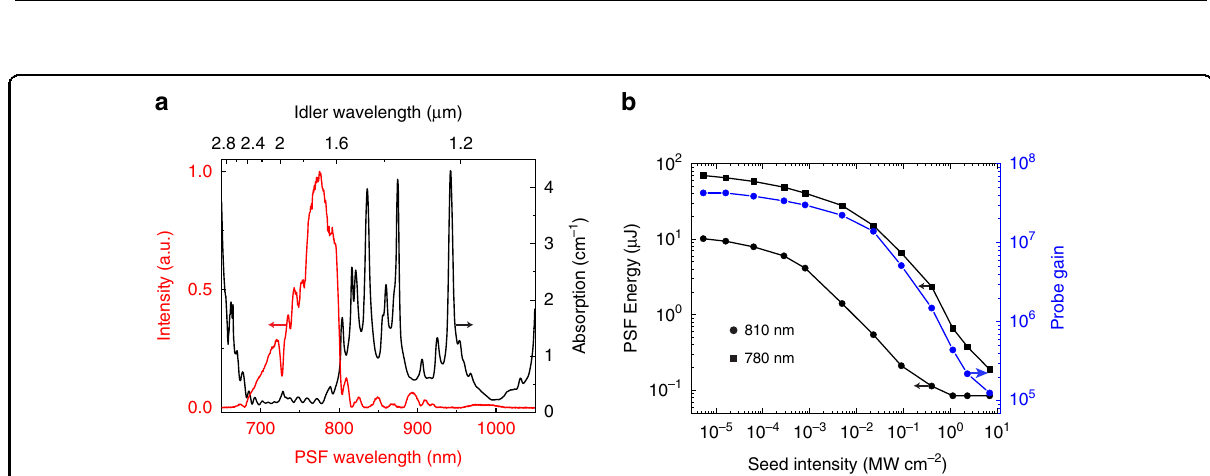
Fig. 4 OPCPA results. a Evolution of signal ef fi ciency (black) and PSF energy (red). b Ampli fi ed signal spectra at seed intensities of 1.6 MW cm − 2 (black curve, point I marked in a ), 130 kW cm − 2 (red curve, point II marked in a ), and 1 kW cm − 2 (blue curve, point III marked in a ), respectively